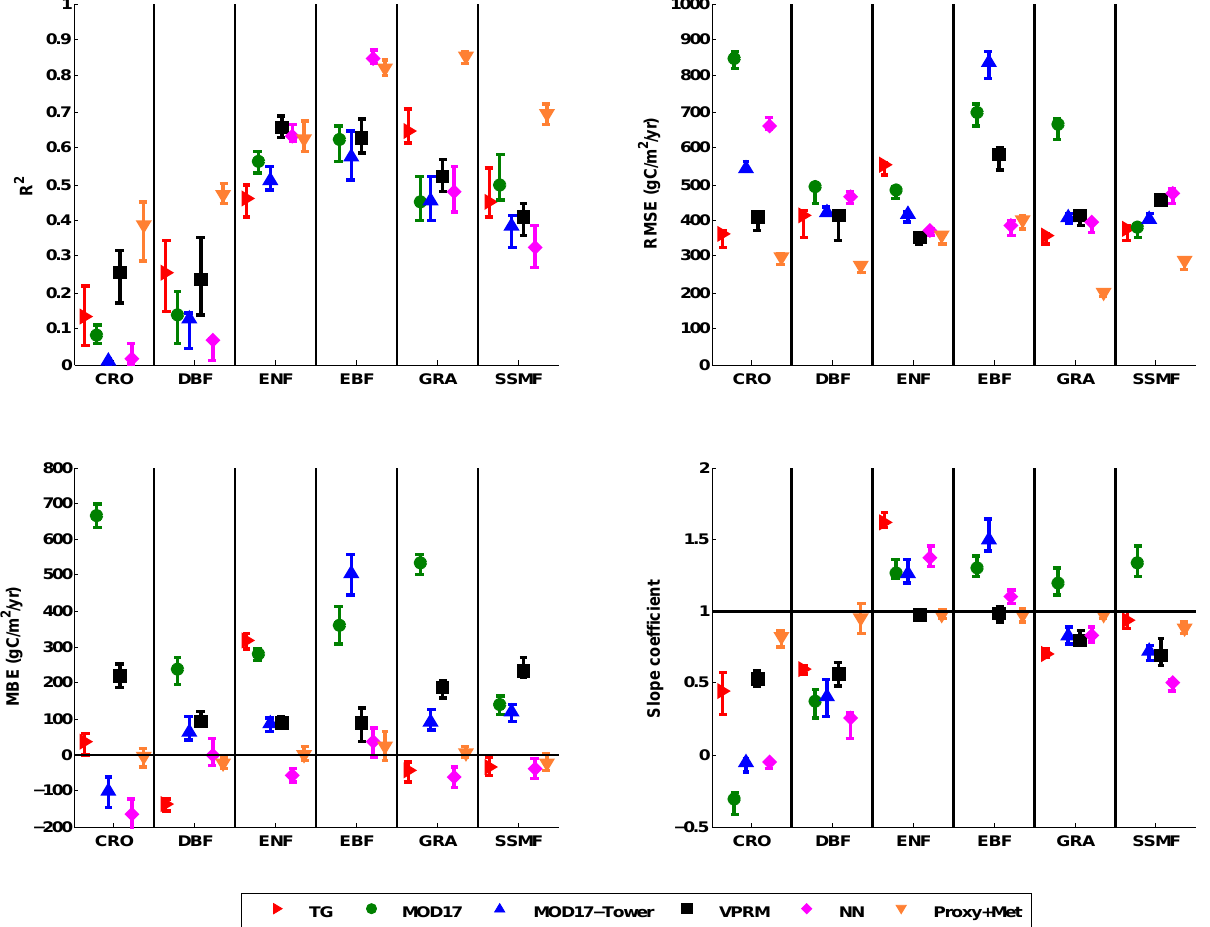
Fig. 4. R 2 , RMSE, MBE, and slope between modeled and measured mean annual GPP predicted from six models. TG model was not evaluated in EBF. RMSE is a measure of mean discrepancy between modeled and flux GPP. It does not distinguish between over- and under-prediction. MBE discriminates between over- and under-prediction and is a measure of mean bias between modeled and tower